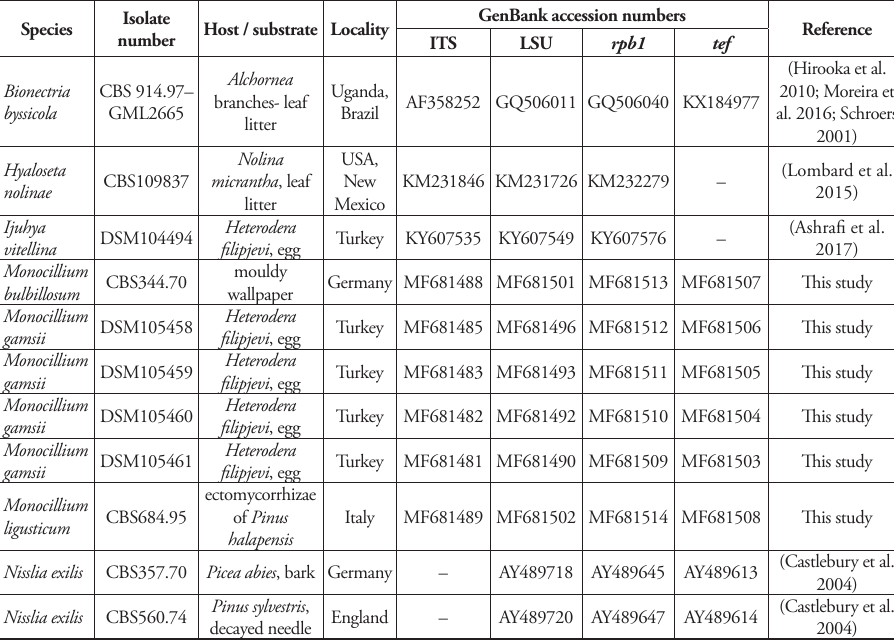
Table 1. Isolates and accession numbers used in the phylogenetic